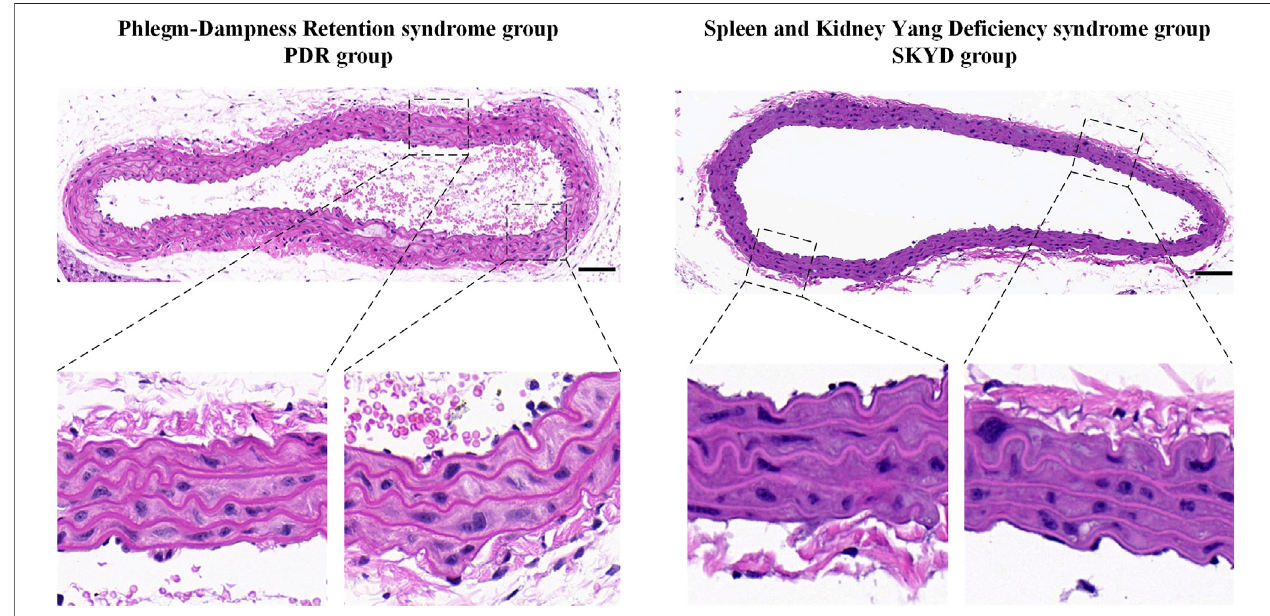
FIGURE 2 | The aorta was stained with hematoxylin and eosin. Scale bars represent 100 μ m.